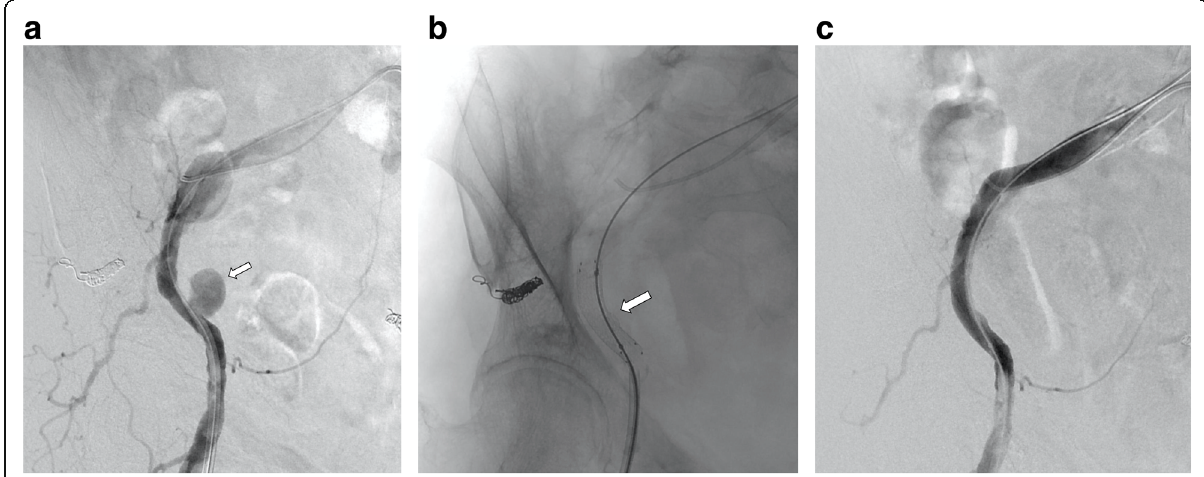
Fig. 2 A 76-year-old woman with right external iliac artery pseudoaneurysm by uterine carcinoma. A Pre-treatment angiogram shows a pseudoaneurysm from the distal site of the right external iliac artery (arrow). B The Viabahn stent graft (9 mm × 5 cm) (arrowhead) is placed at the external iliac artery. The coils in the internal iliac artery were used for the previous treatment of uterine carcinoma. C Angiogram after endovascular therapy with a Viabahn stent graft shows disappearance of the pseudoaneurysm without